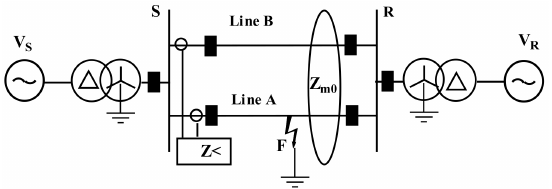
Figure 8. Mutual compensation using the zero-sequence current from line B into the ground distance relay in line